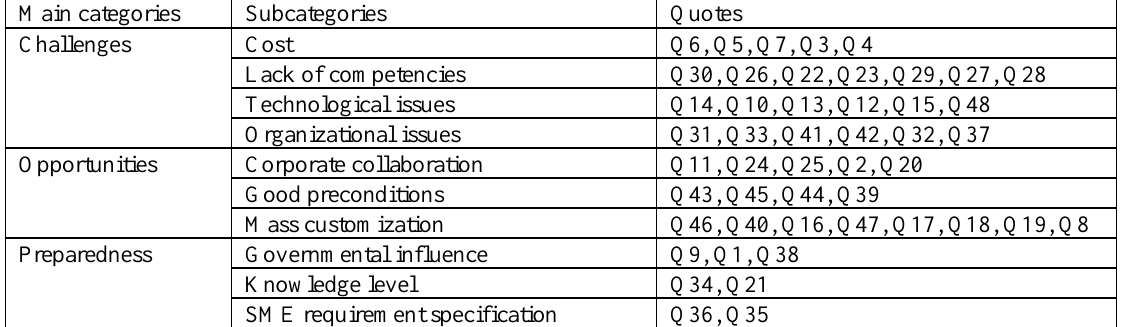
Table 3. Literature review findings concerning challenger opportunities and